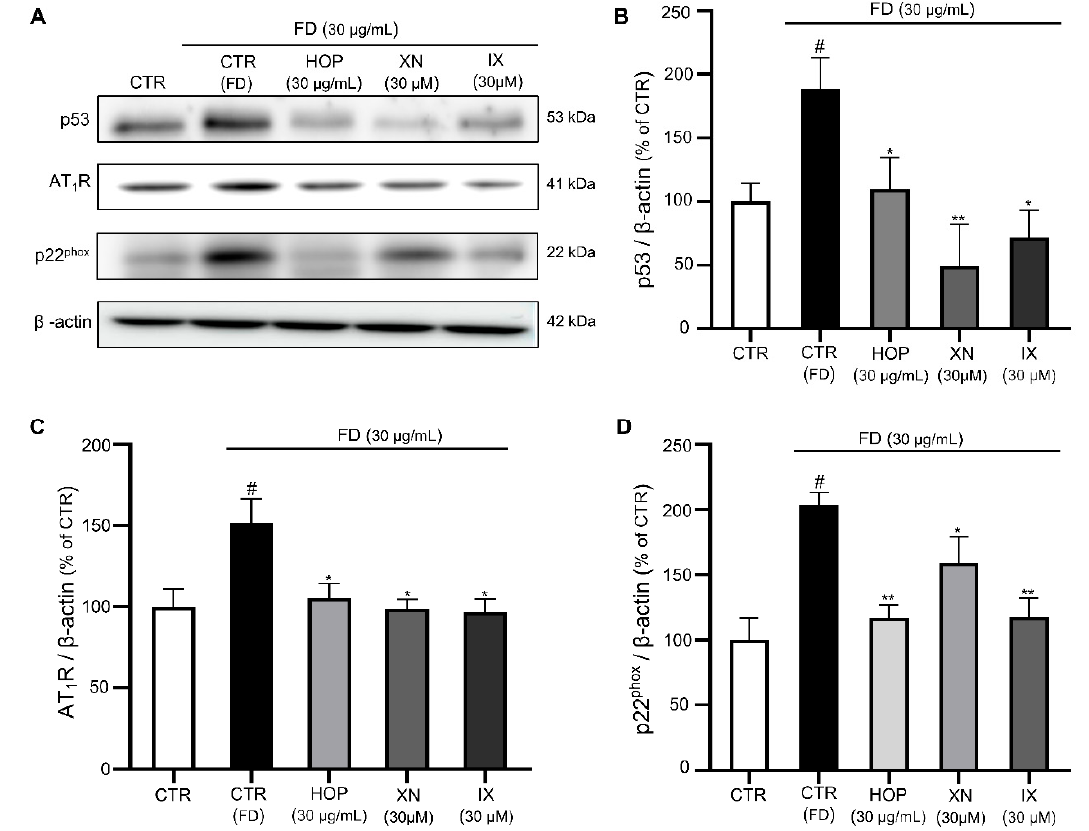
Figure 5. HOP and its active compounds XN and IX reduce the expression of p53, AT 1 R, and p22 phox . ( A ) Representative blots of p53, AT 1 R, and p22 phox proteins of ECs in presence of FD alone or in combination with HOP extract and XN / IX. ( B–D ) Corresponding cumulative data of p53, AT 1 R, and p22 phox , respectively. Data are expressed as the mean ± SEM ( n = 3); # p < 0.05 vs. control (CTR); ** p < 0.01, *** p < 0.001 vs. FD alone (CTR-FD).